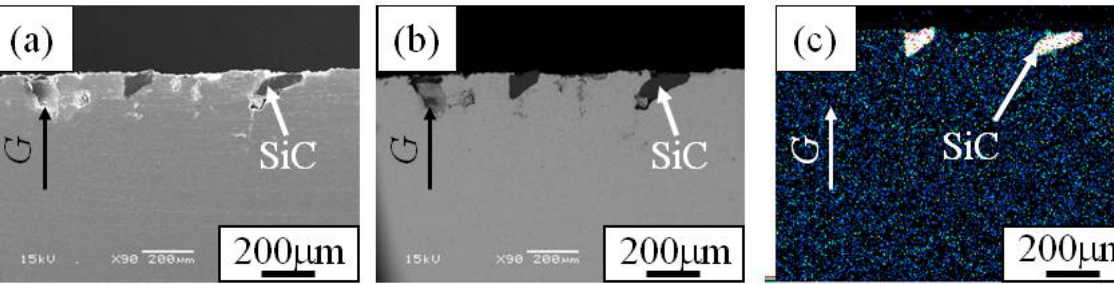
Figure 7. Microstructures of the cross-section of Specimens 1. (a) SE Image, (b) Compo Image and (c) Si distribution map by EDX [17].